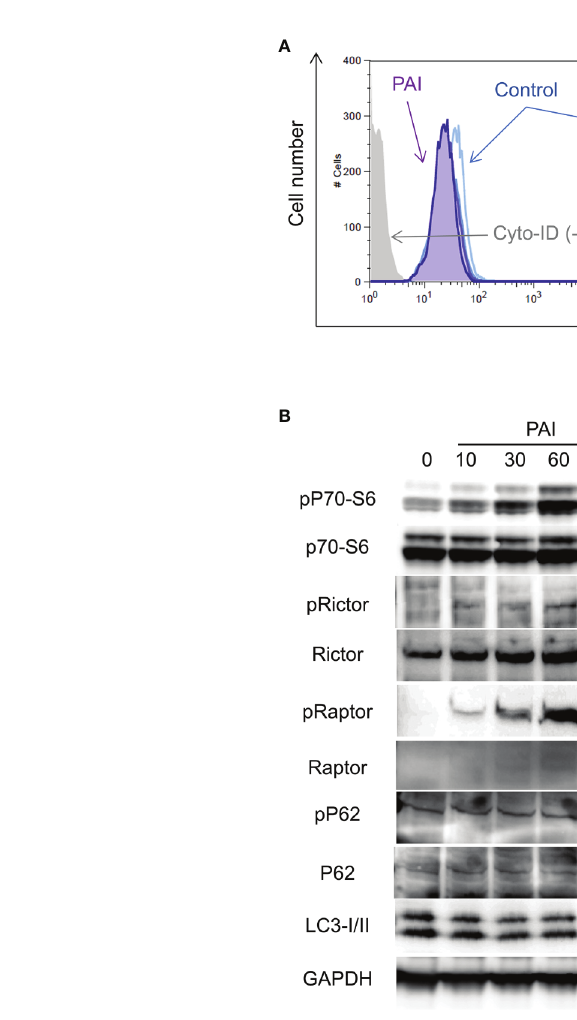
FIGURE 3 | PAI reduces autophagic fl ux by promoting the mTOR complex pathways. (A) LM8 cells were loaded with Cyto-ID and treated with PAI (50%) or rapamycin (positive control) for 18 h and analyzed by fl ow cytometry. (B) LM8 cells were treated with PAI (50%) for the indicated time and then analyzed for the expression of p70-S6 kinase, Rictor, Raptor, p62, and LC3-I/II, and their phosphorylated forms by western blotting analysis using speci fi c antibodies. GAPDH was used as a loading control. See Supplementary Figures 3 , 4 for examples of uncropped images and quanti fi cation for each